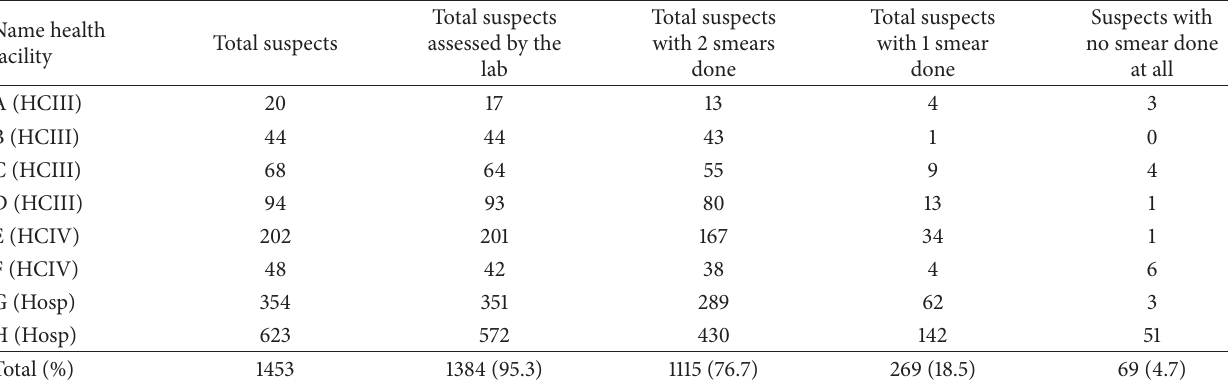
Table 5: Number of ZN tests performed by laboratories for suspects captured in Kamuli district health facilities for the year 2010. Name